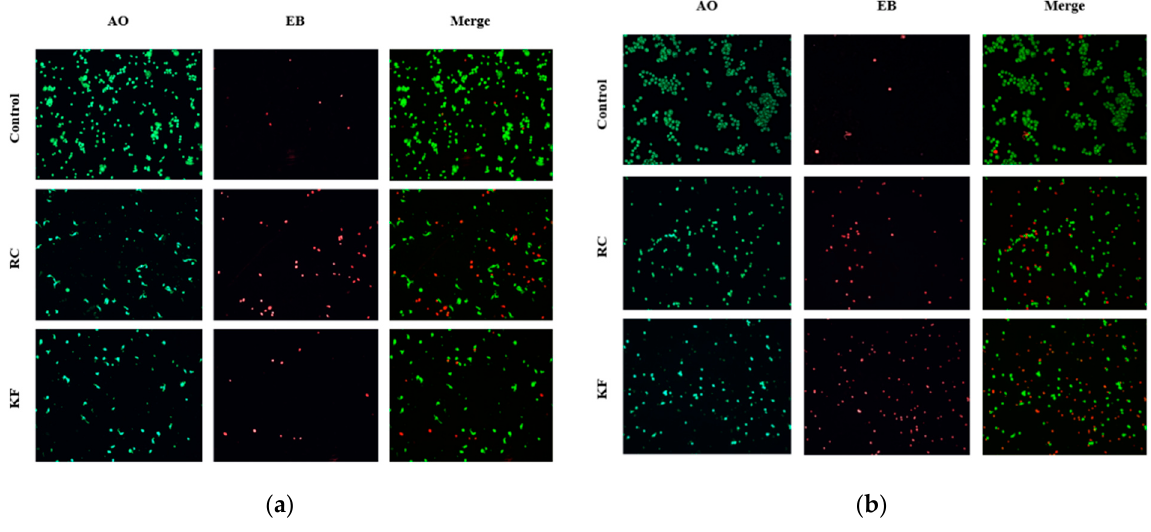
Figure 3. Staining of Rd ( a ) and HOS ( b ) line cells with a mixture of fluorescent dyes (AO and EB) after 72 h of incubation with kudzu flower (KF) and clover (RC) extracts at a concentration of 64 μ g/mL compared to intact cells (Control). Healthy or control cells and apoptotic bodies were visualized with green fluorescence, whereas necrotic cells and late apoptotic cells appear with red fluorescence. Images were captured at original magnification, ×